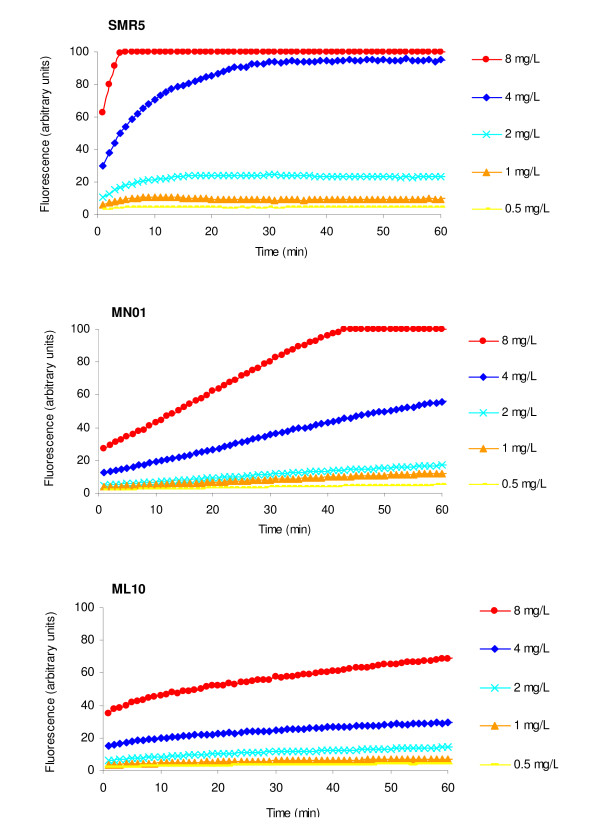
Accumulation of increasing concentrations of EtBr (0.5-8 mg/L) by M. smegmatis SMR5, MN01 (ΔmspA) and ML10 (ΔmspAΔmspC).